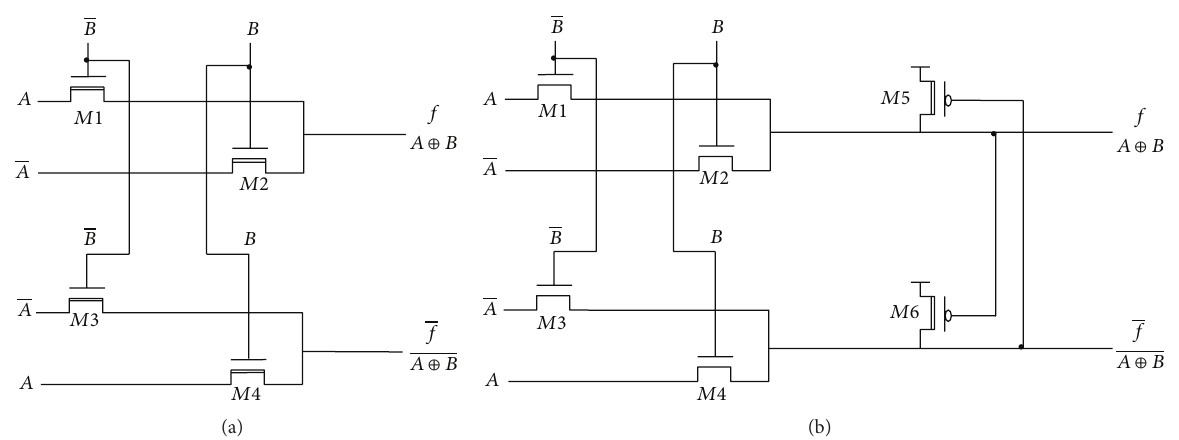
Figure 6: CPL logic with multiple threshold voltage transistor: (a) NMOS transistors; (b) PMOS